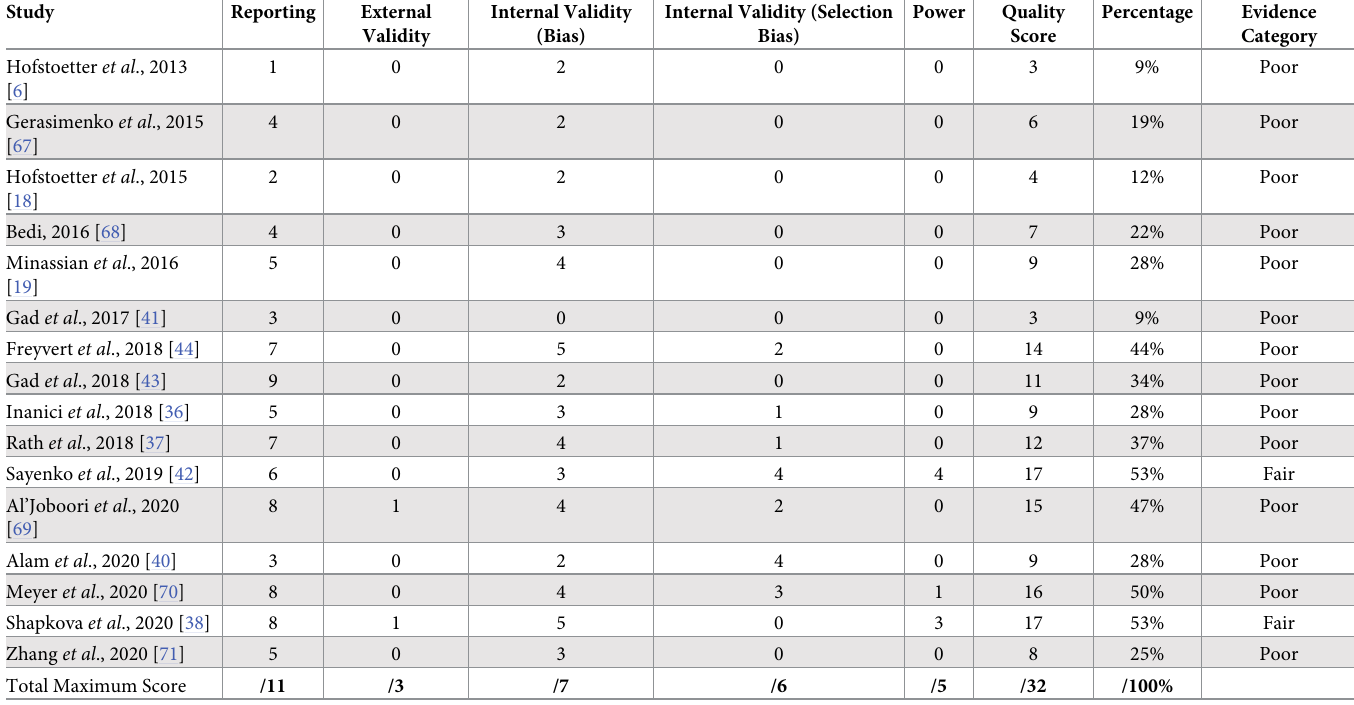
Table 5. Results from the quality appraisal of therapeutic investigations using the Down’s and Black Checklist. Quality of Evidence Assessment–Therapeutic